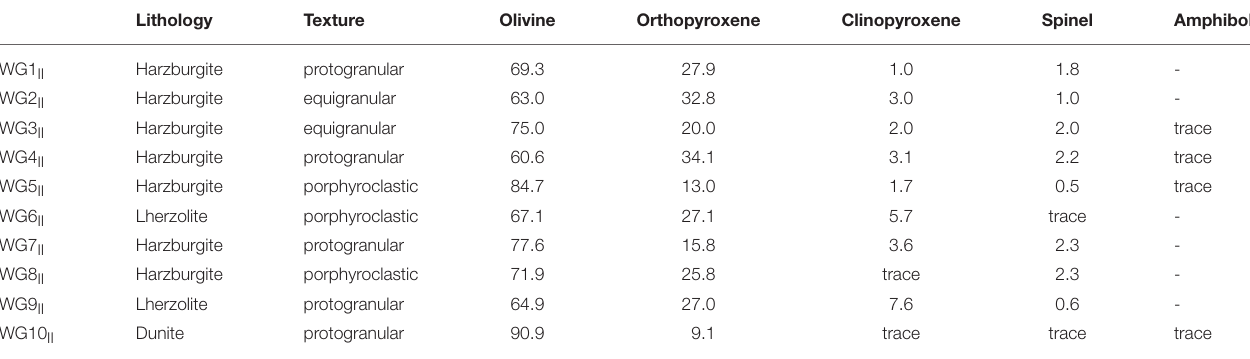
TABLE 1 | Textural features and modal composition of Wilcza Góra xenoliths. Modal content of phases by volume